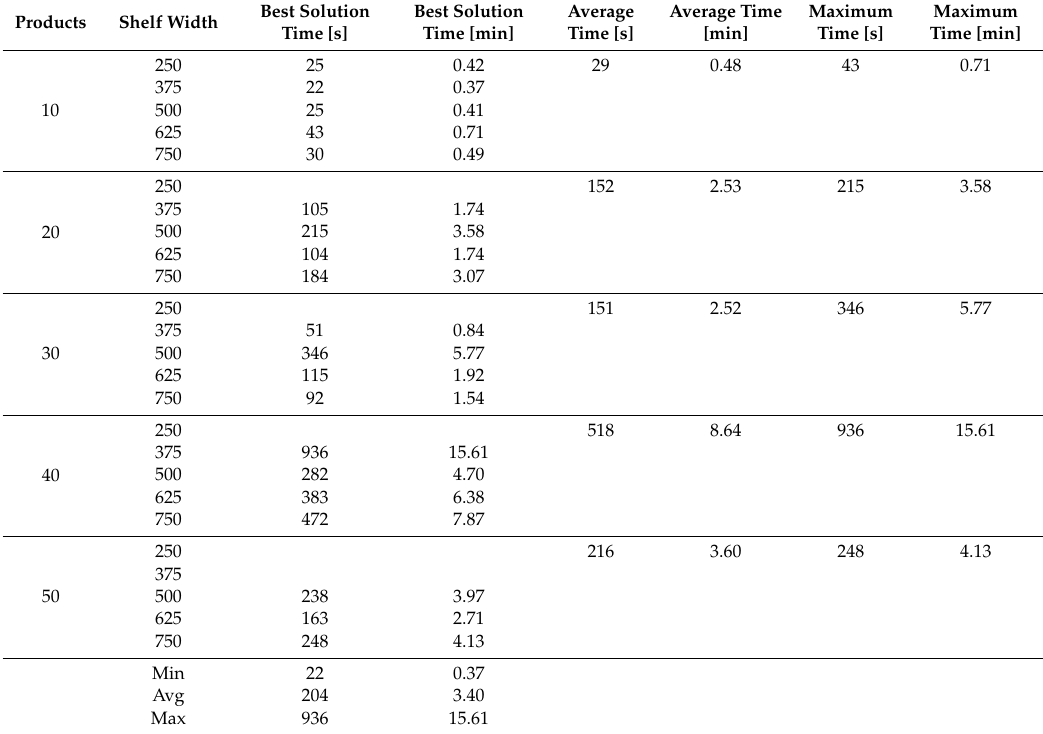
Table 5. Time of the best solution, average, and maximum times for each product